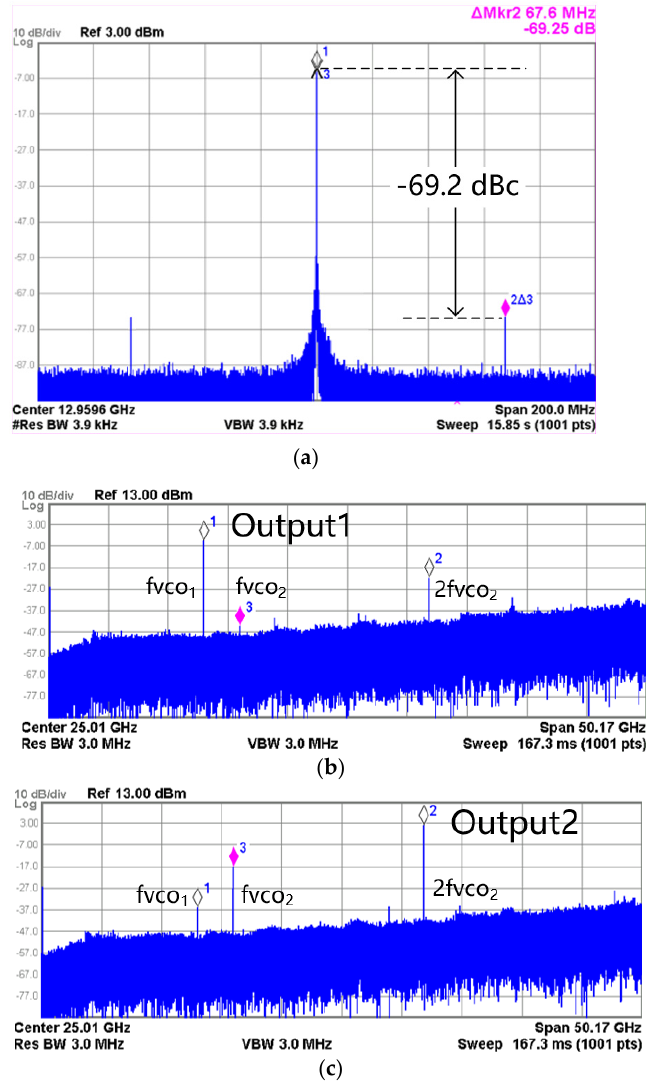
Figure 11. Measured output spectrum for the dual-loop dual-output synthesizer: ( a ) reference spur level of − 69.2 dBc at Output1; ( b ) full-span spectrum of Output1 with fvco1 as the main output frequency and 2fvco2 as the second peak; ( c ) full-span spectrum of Output2 with 2fvco2 as the main output frequency and fvco2 as the second peak. Table 1. Comparison of state-of-the-art frequency synthesizers for communications. Ref.